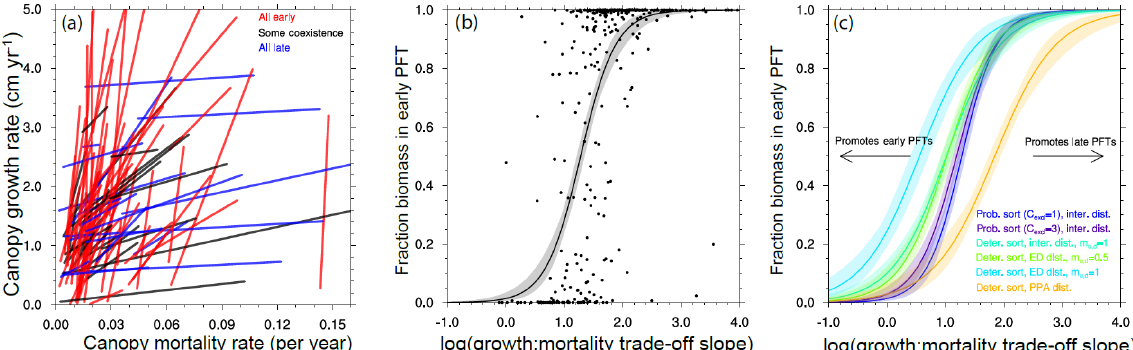
Figure 13. Competitive outcomes between two PFTs as a function of PFT growth and mortality rates along an early–late-successional continuum. Only ensemble members where a successional trade-off, i.e., one of the PFTs both grows and dies faster than the other PFT, are shown. (a) The lines connecting paired PFTs in a growth–mortality trade-off space, for a random subset of ensemble members in the reference case, are colored by the competitive outcome in each member to show the importance of the slope of the trade-off line in determining the outcome. (b–c) The relative fraction of total ecosystem biomass in the faster, early-successional PFT is plotted against the log of the ratios of the slope of the growth–mortality trade-off in each PFT pairing. Curves in (b) – (c) show a continuous logistic regression as applied to the PFT biomass fractions in each experiment. Panel (b) shows the individual ensemble members as well as the logistic regression for the reference case. Panel (c) shows only the logistic regression fit for each of the cases, demonstrating that the parameter uncertainty related to disturbance and height sorting that differentiates each ensemble leads to divergent outcomes in the relative success between early- and late-successional PFTs. See Fig. 1 for qualitative schematics of the different structural cases.